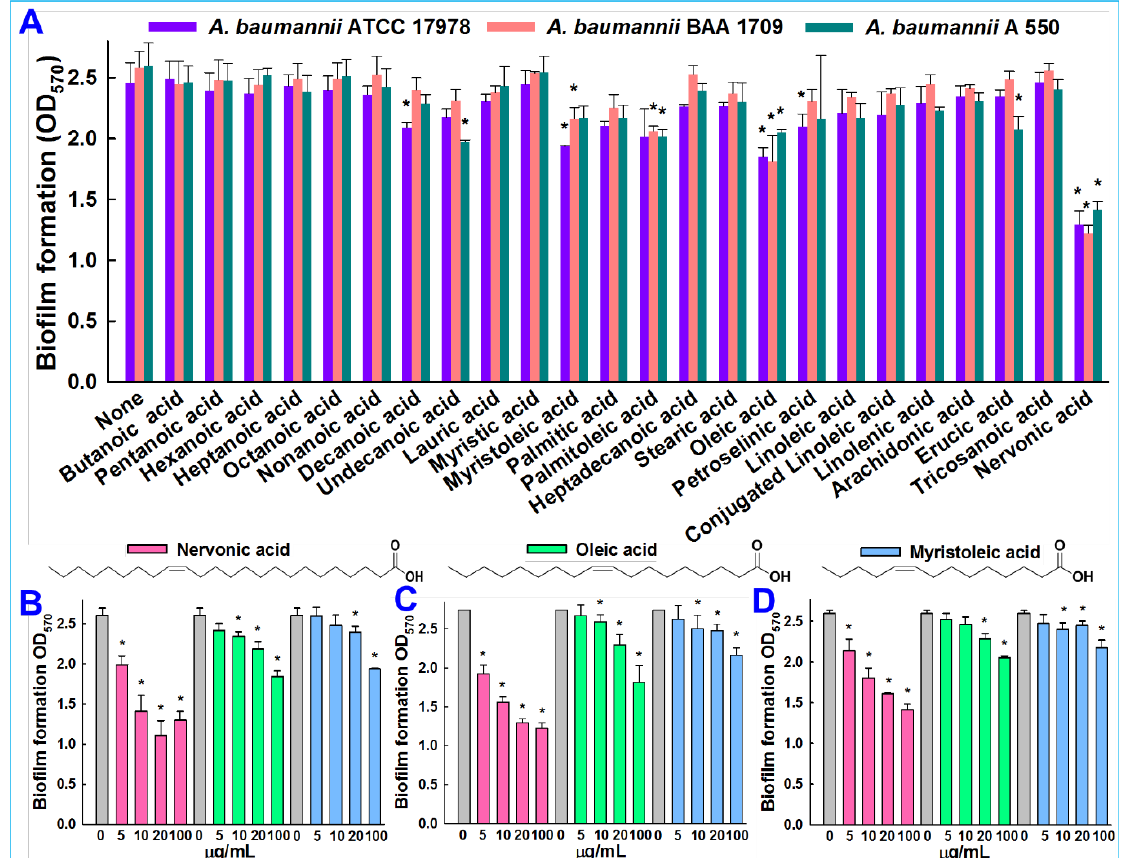
Figure 1. Impacts of various fatty acids on biofilm formation by the three A. baumannii strains in the presence of fatty acids at 100 μg/mL ( A ), The structures and antibiofilm activities of the selected fatty acids against the three strains of A. baumannii were quantified against A. baumannii ATCC 17978 ( B ), A. baumannii BAA 1709 ( C ), and A. baumannii A 550 ( D ). Error bars indicate standard deviations. *, p < 0.05 versus non-treated controls.